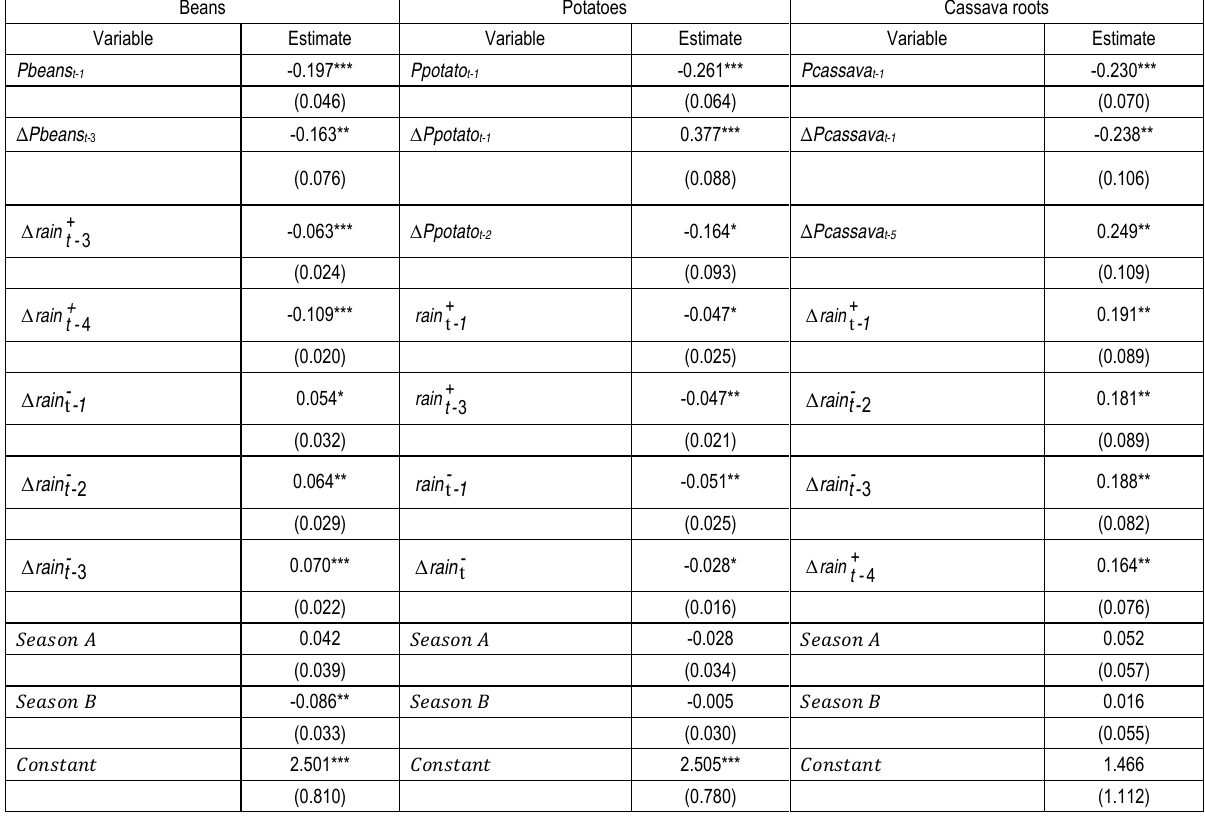
Table 3. Dynamic asymmetries in the price of beans, potatoes and cassava